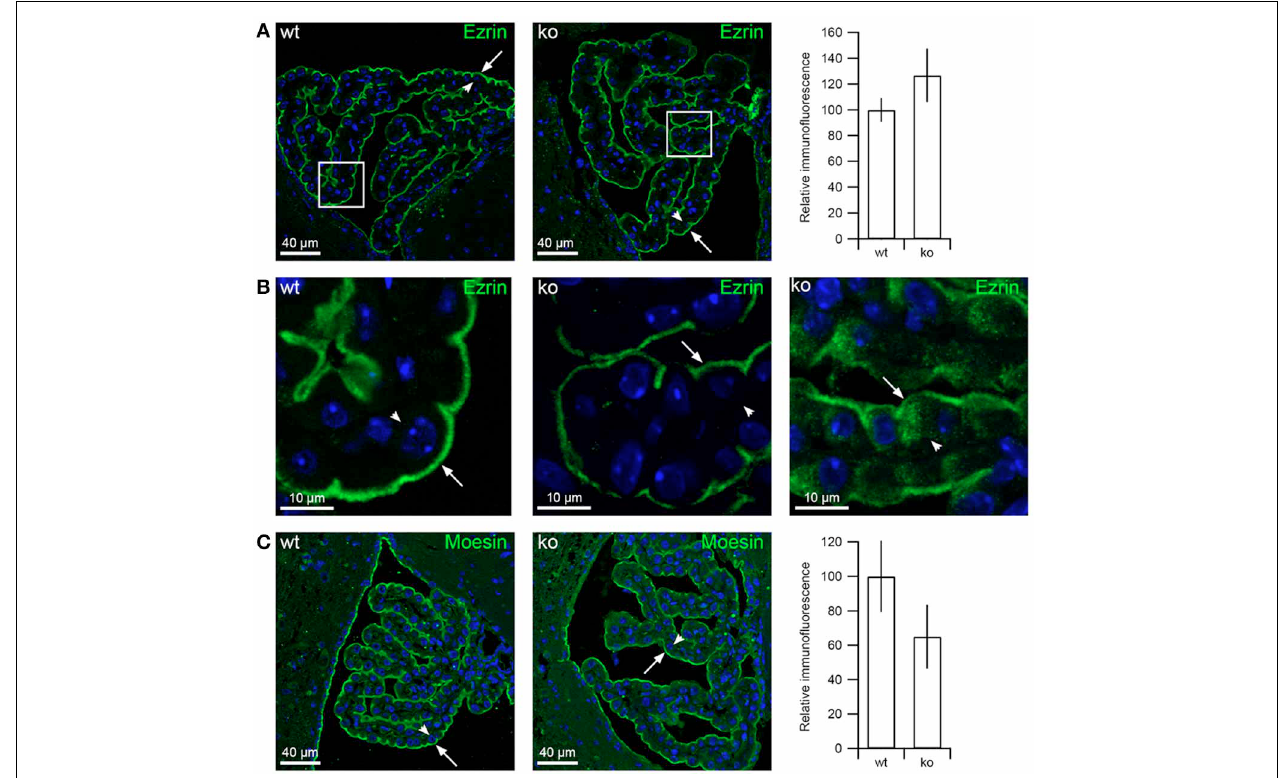
FIGURE 4 | Ezrin and moesin expression in CPE from slc4a10 wt and ko mice. Mouse brain sections were immunofluorescence stained with ezrin and moesin antibodies (in green). (A) Immunohistochemical detection of ezrin in slc4a10 wt and ko, as indicated. Bar graph on the right show the semi-quantitation of the ezrin immunofluorescence in slc4a10 wt and ko mouse CPE (wt: n = 5, ko: n = 4). (B) Immunohistochemical detection of